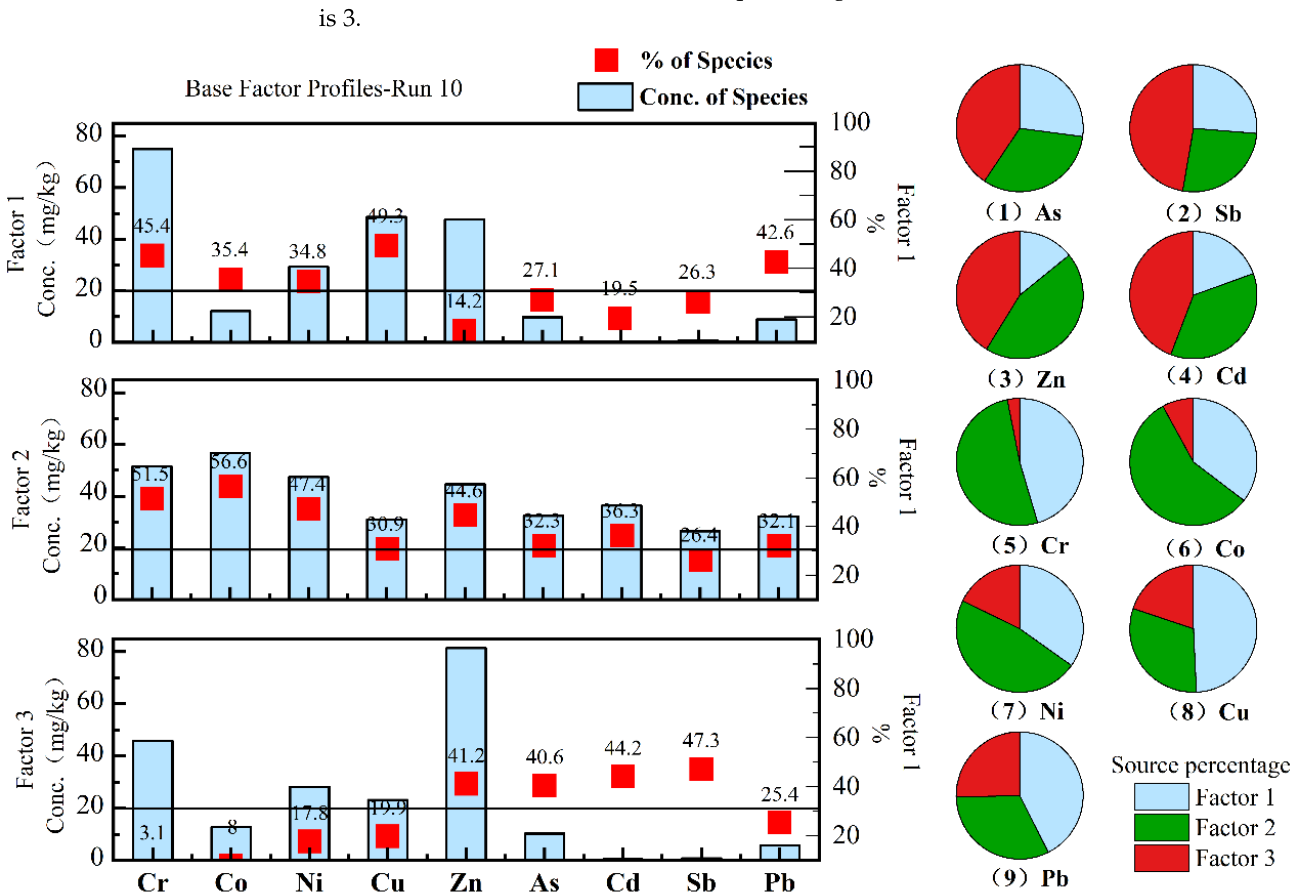
Figure 4. Contribution value, contribution rate and source percentage of As and HMs concentrations in sediments obtained by the PMF model.